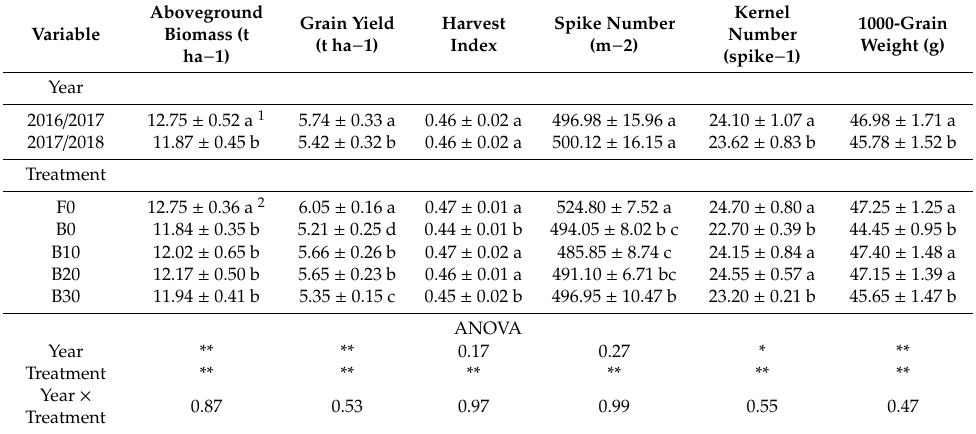
Table 9. E ff ect of year and treatment on aboveground biomass, grain yield, harvest index, spike number, kernel number, and 1000-grain